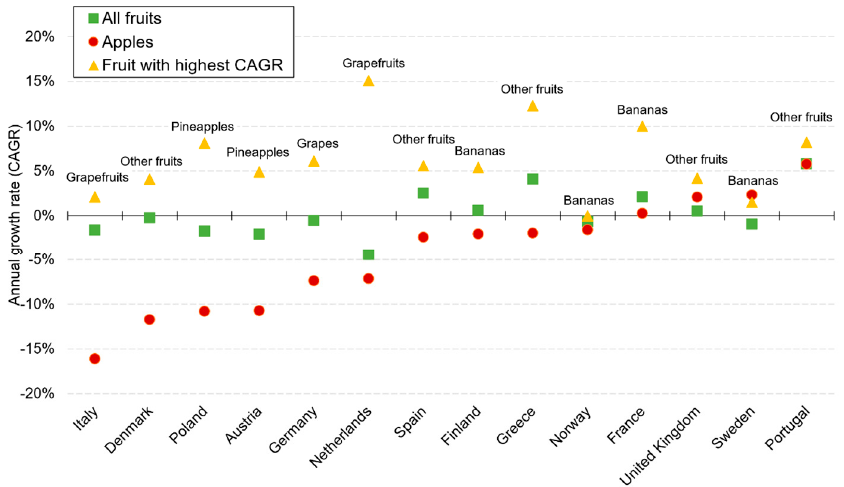
Figure 1. Average annual growth (2014–2017) in yearly per capita consumption (in kg) of total fruits, apples and the fastest growing fruit category, selected European countries (CAGR = compound annual growth rate).